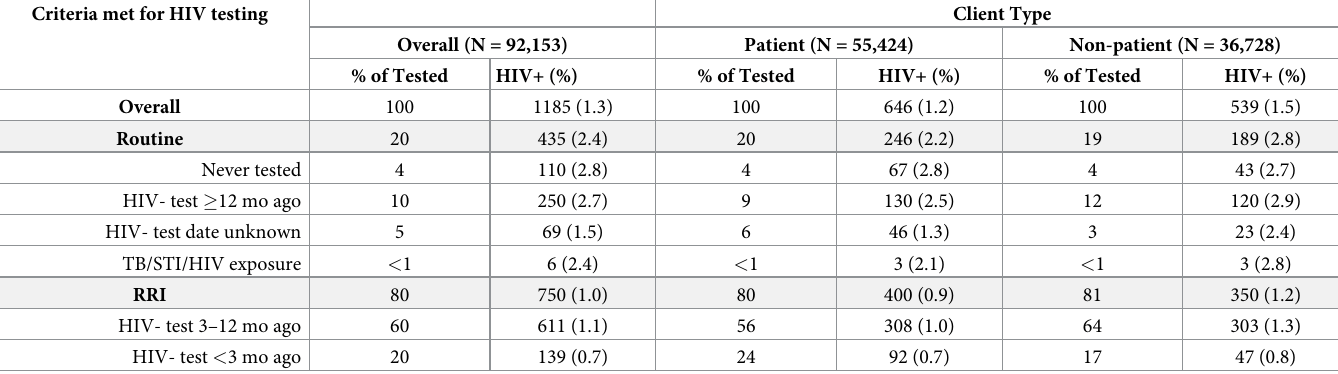
Table 2. HIV diagnoses by eligibility criteria met for HIV testing among patients and non-patients tested for HIV at selected facilities in Siaya, Kisumu and Homa Bay Counties, Kenya. Criteria met for HIV